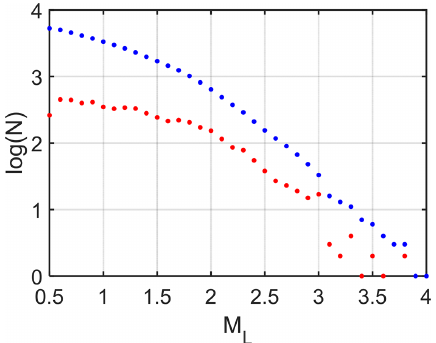
Figure 8. Cumulative (blue) and non-cumulative (red) magnitude– frequency distribution of the analysed